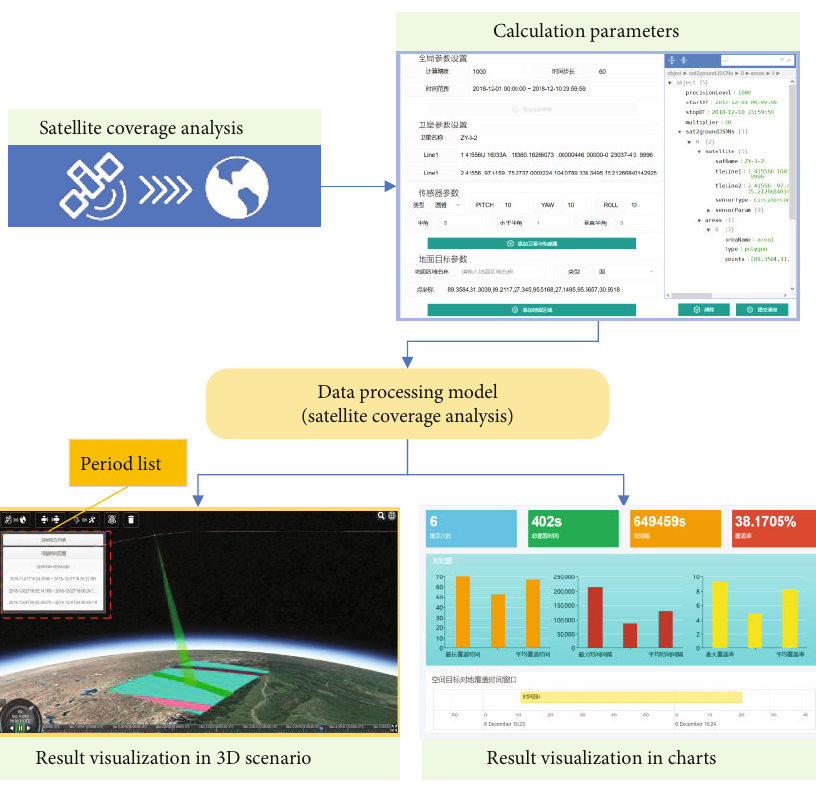
Figure 14: Execution fl ow and visualization of the satellite coverage analysis.